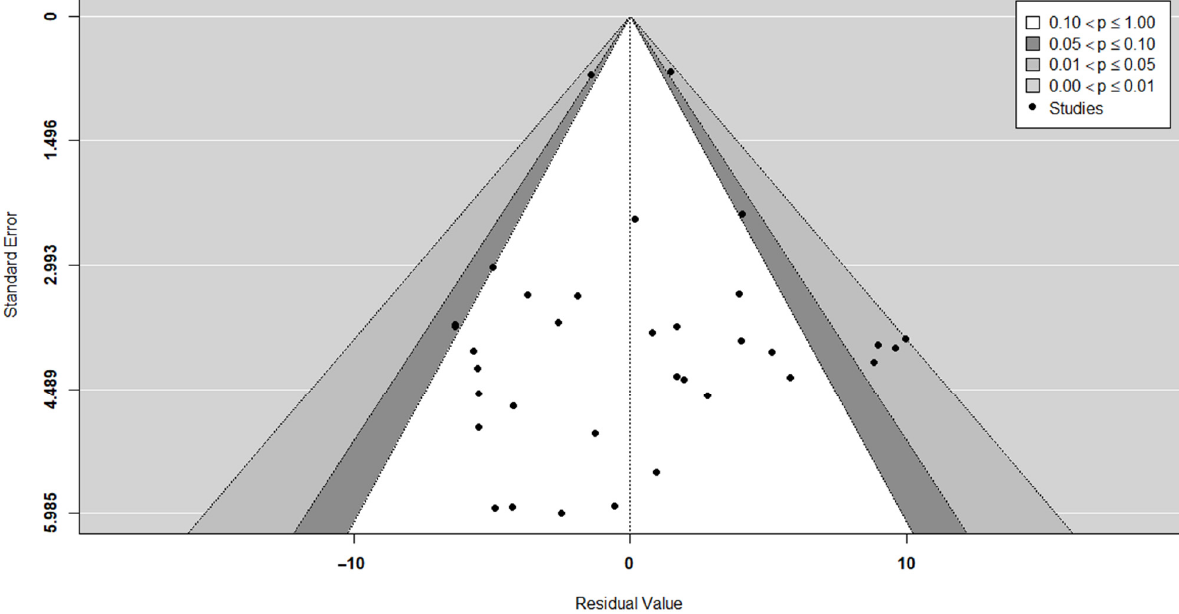
Figure 2. Contour enhanced funnel plot of the residuals of plant species richness response to different levels of nitrogen addition from studies when fitted with a mixed effect linear model.